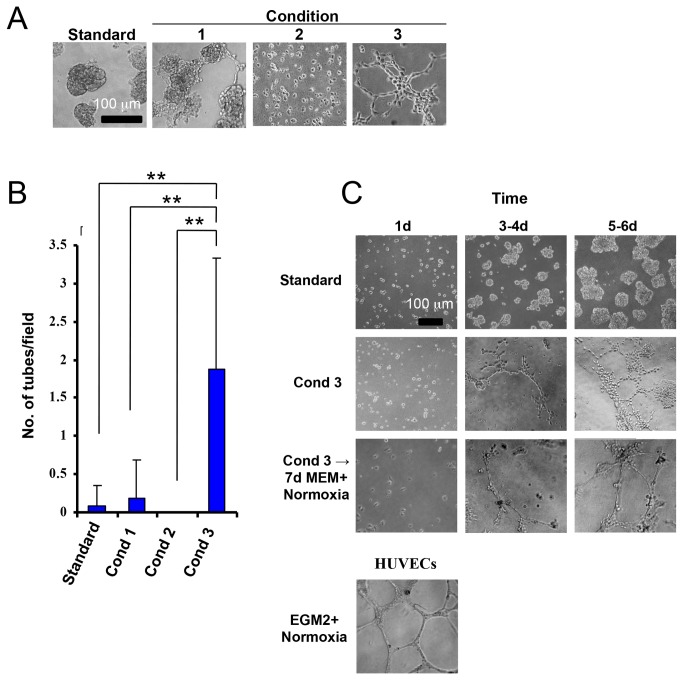
Tube formation by TDECs.(A) H460 tumor cells were induced to form TDECs by 5 d of exposure to the indicated conditions. 2 x 104 cells from each group were then plated on Matrigel in a tube formation assay under normoxic conditions for 5 d, as previously described [24,25]. Untreated H460 cells grown under standard conditions served as controls. Typical light microscopic fields are shown. All photos are shown at identical magnifications. (B) The results shown in (A) are graphically depicted as the mean number of completely enclosed tubes per field ± SEM. p values were obtained using one-way ANOVA (**: p < 0.01). (C) H460 tumor cells were grown under standard conditions or condition 3 for the indicated times. Half the cells were then immediately plated on Matrigel and grown under normoxic conditions for an additional 6 d. The remainder of the cells were returned to standard conditions for 7 d prior to being plated in Matrigel for 6 d to assess the persistence of tube-forming potential. HUVECs were used as a positive control for tube formation. Brightfield photographs were taken at 10X magnification. Similar results were obtained in four independent experiments (A) and two independent experiments (C). Scale bar = 100 um.